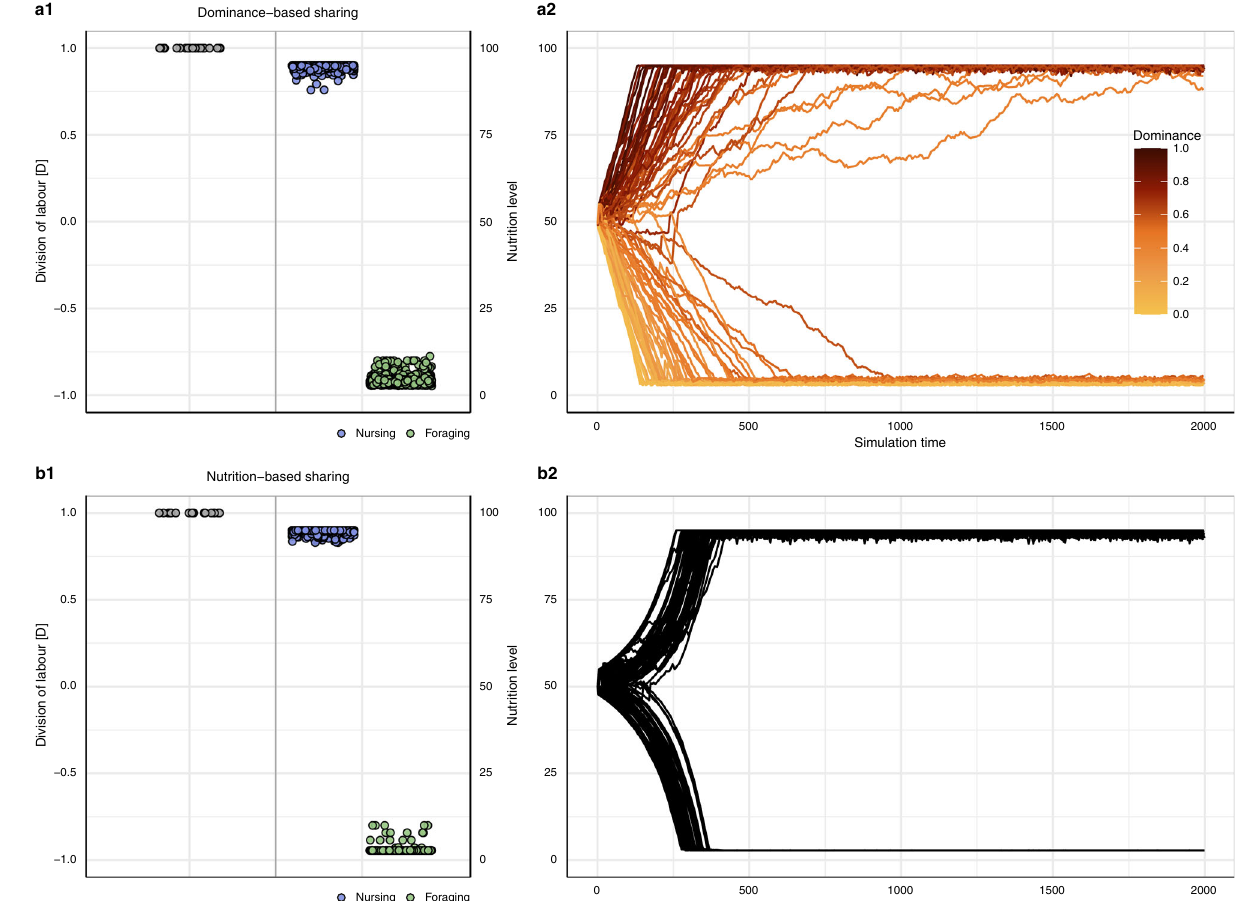
Fig. 4 | Division of labour, nutrition level and dominance of nursing and fora- gingindividuals.a1 Dominance-basedsharing.Divisionoflabourreachesmaximal levels of D =1. Nursing and foraging individuals exhibit a bimodal distribution of nutrition levels. a2 Nutrition levels of individuals diverge over simulation time, depending on the individual ’ s dominance. b1 Nutrition-based sharing. Division of labour again reaches maximal levelsof D =1, and nutrition levels exhibita bimodal